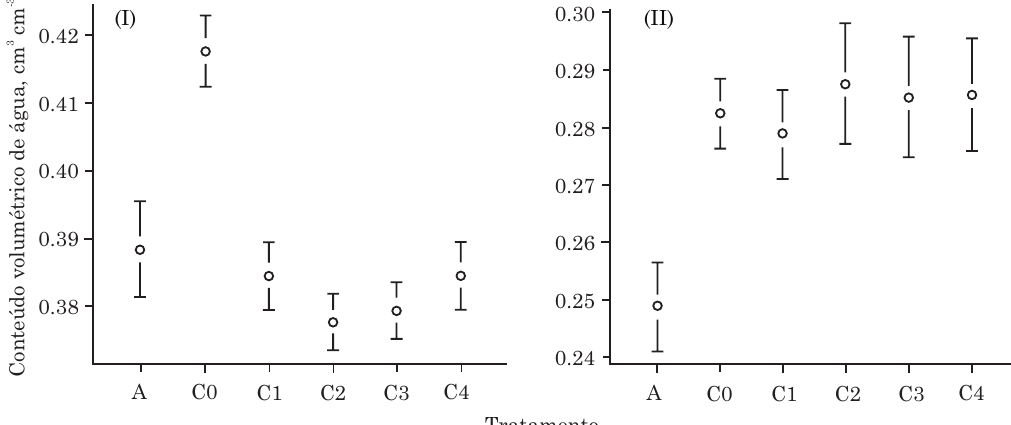
Figura 3. Valores médios de conteúdo volumétrico de água de dois Latossolos Vermelhos distróficos, um argiloso (I) e um franco-argilo-arenoso (II), nos tratamentos A, C0, C1, C2, C3 e C4. As barras representam o intervalo de confiança da média (85